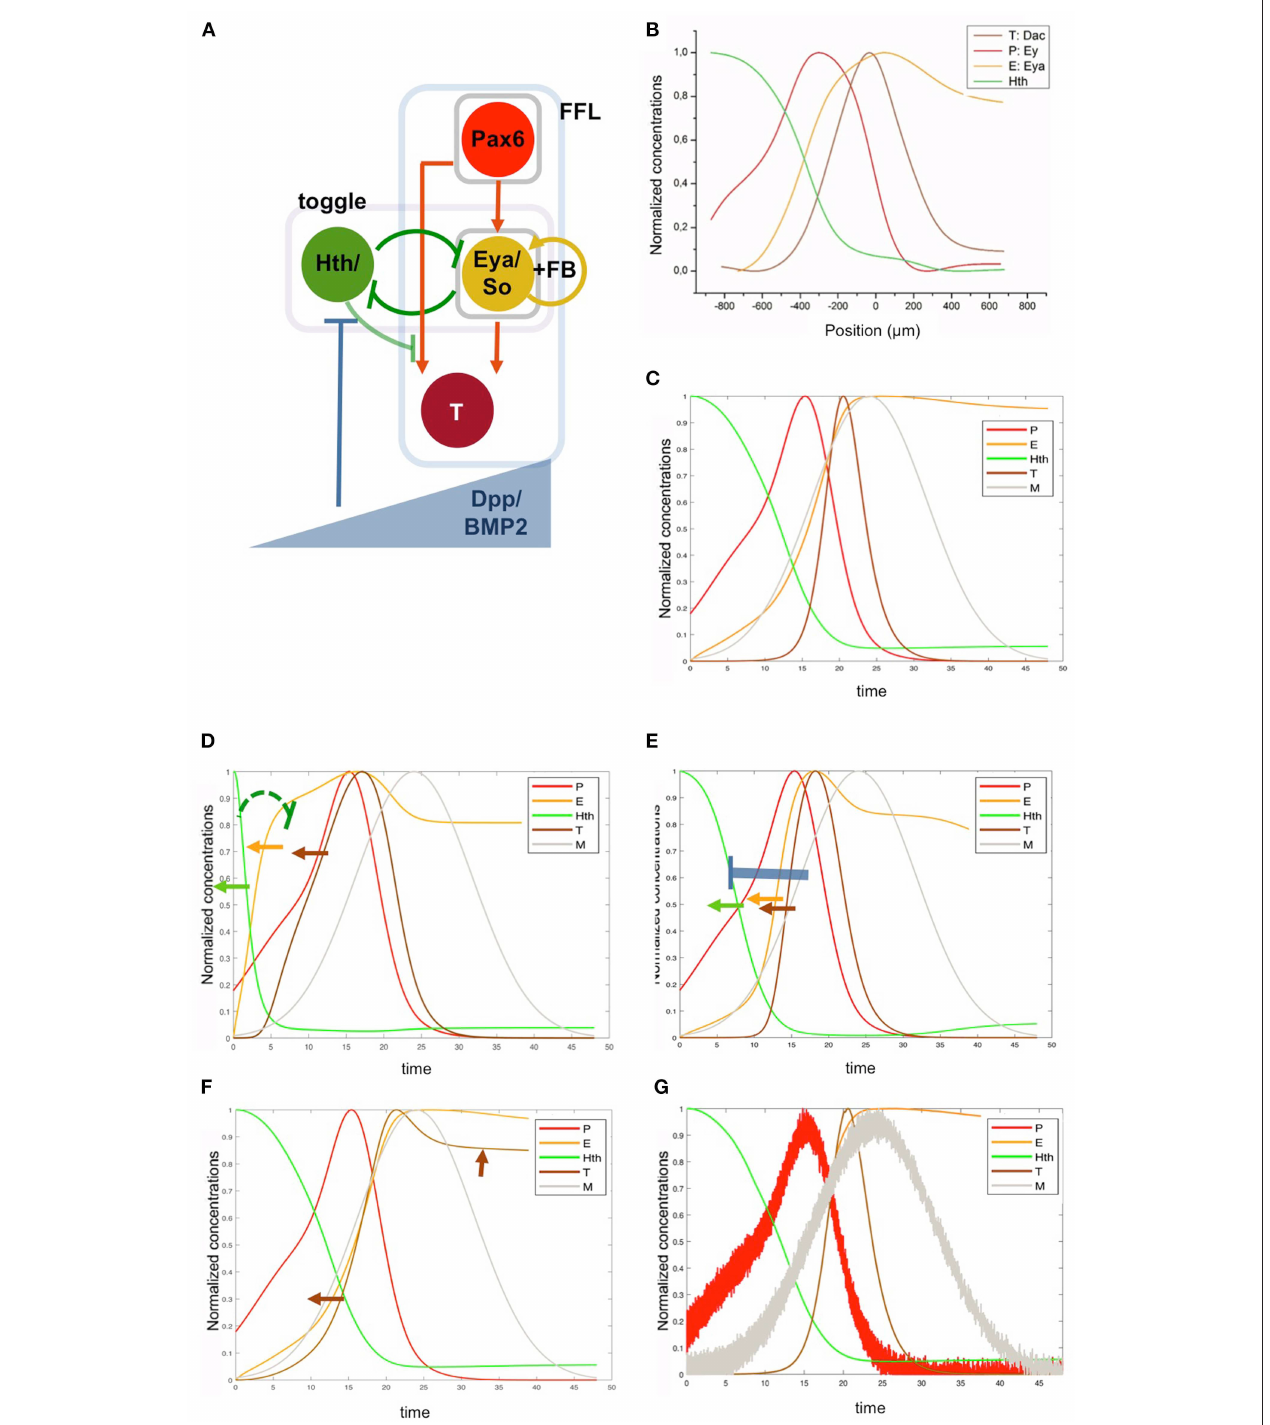
FIGURE 5 | A gene regulatory network with intertwined feed-forward loop and toggle-switch motifs recapitulates the RDGN expression profiles. (A) The basic RDGN. The function of ey and toy has been grouped as “Pax6.” The mutual activating loop between Eya and So has been simplified as a positive feedback autoregulatory loop (“FB”). Coherent feedforward loop motif (FFL) and toggle-switch motif (“toggle”) have been boxed. A potential repression from Hth to targets has been included (as light negative link), but is not required to retrieve the experimental pattern. “T” represents a generalized target gene, such as dac, stg , or ato. A gradient of Dpp, produced by the differentiation wavefront, animates the network. (B) Normalized experimental expression profiles. (C) Gene network model-generated expression profiles. Note that while the x axis in (B) is distance, x has time units in (C) . This is because, as the differentiation speed is constant, the gene expression